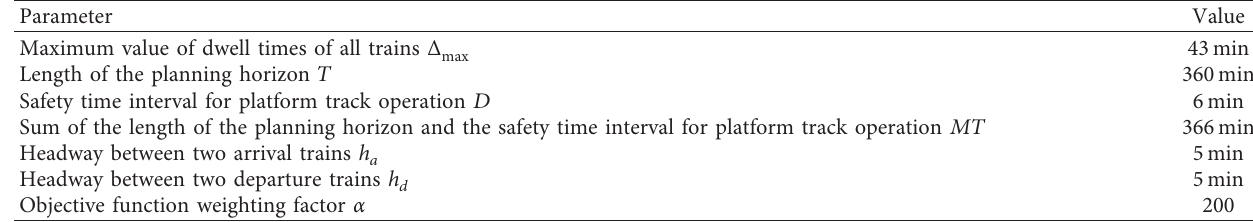
Table 7: Input parameters of the model.